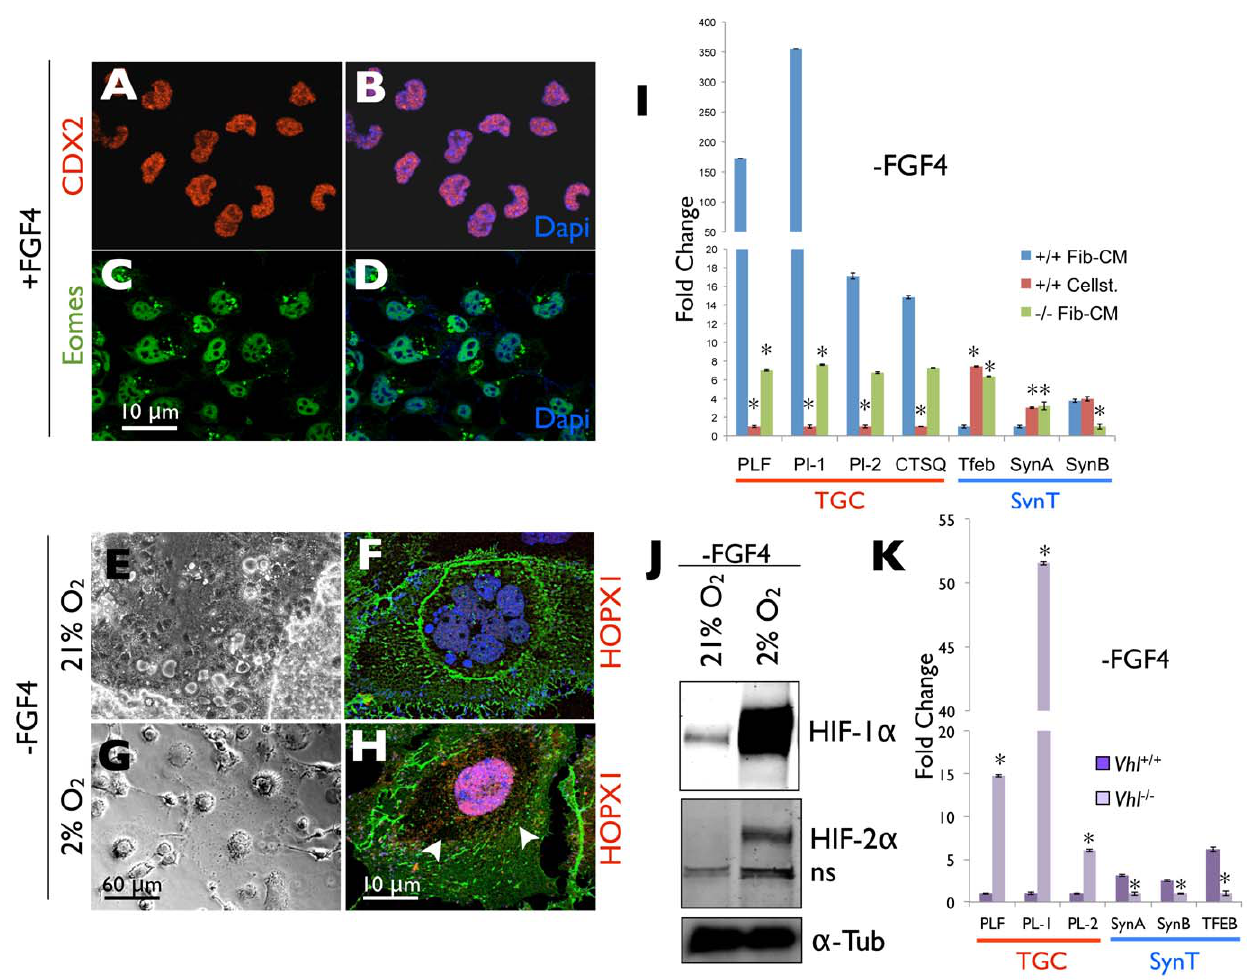
Figure 1. HIF integrates ECM cues and Oxygen Levels to Direct TSC Fate. (A–D) Immunofluorescence microscopy of undifferentiated control TSCs cultured on CELLstart TM with anti-CDX2 and EOMES antibodies (blue=DAPI, red=CDX2, green=Eomes). (E, G) Phase contrast microscopy of control TSCs maintained on CELLstart TM following differentiation for 7 days under normoxic (21% O 2 ) or hypoxic (2% O 2 ) conditions. (F, H) Immunofluoresce microscopy of control TSCs maintained on CELLstart TM following differentiation for 7 days under normoxic (21% O 2 ) or hypoxic (2% O 2 ) conditions with an anti-HOPX1 (red) antibody (blue=DAPI). (I) Quantitative RT-PCR analysis of Pl. I, Pl.II, Ctsq, Plf, Tfeb, SynA and SynB gene expression in wild-type ( + / + ) TSCs differentiated for 7 days following culture on CELLstart TM or on TC plastic in Fib-CM, compared with Arnt 2 / 2 ( 2 / 2 ) TSCs differentiated following culture on TC plastic in Fib-CM. p values , 0.05 versus wild-type Fib-CM indicated by an asterisk. (J) Immunoblot of HIF- 1 a and -2 a protein levels in whole cell lysates of wild-type TSCs differentiated for 7 days following culture on CELLstart at 21%O 2 or 2% O 2 . (K) Quantitative RT-PCR analysis of Pl-1, Pl-2, Plf, Tfeb, SynA and SynB expression in Vhlh + / + and Vhlh 2 / 2 TSCs differentiated following culture on CELLstart TM . p values , 0.05 versus wild-type indicated by an